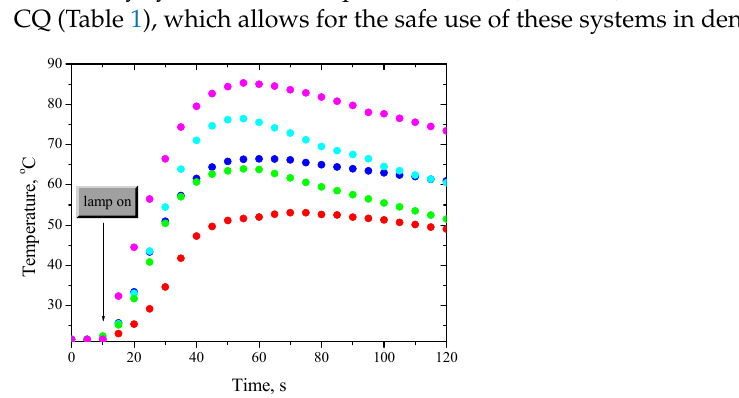
Figure 1. Comparison of temperature changes during irradiation of monomer composites containing synthesized photoinitiators and commercial camphorquinone. Photoinitiating systems include: —CQ (camphorquinone) as photoinitiator, and 1-naphthoxyacetic acid (NAA; c = 0.1 M) as co-initiator. I = 15 mW/cm 2 .